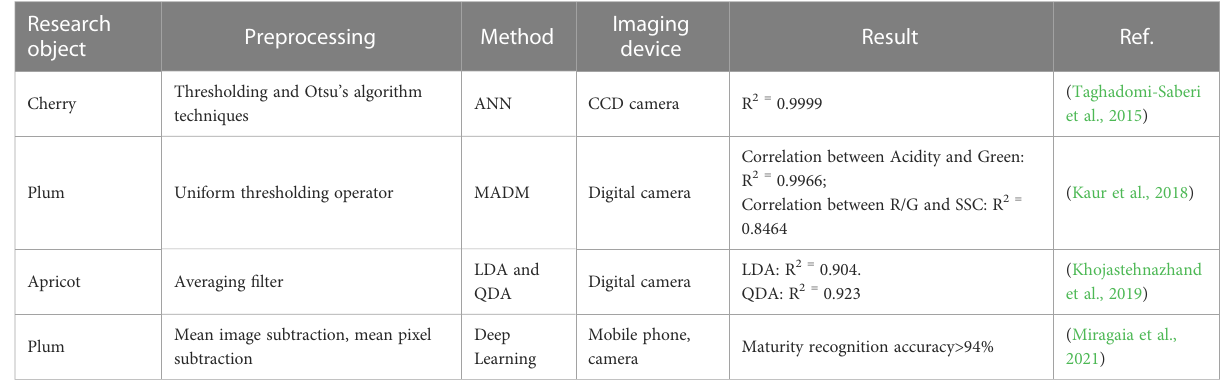
TABLE 2 Review on fruit maturity detection based on phenotypic information using RGB